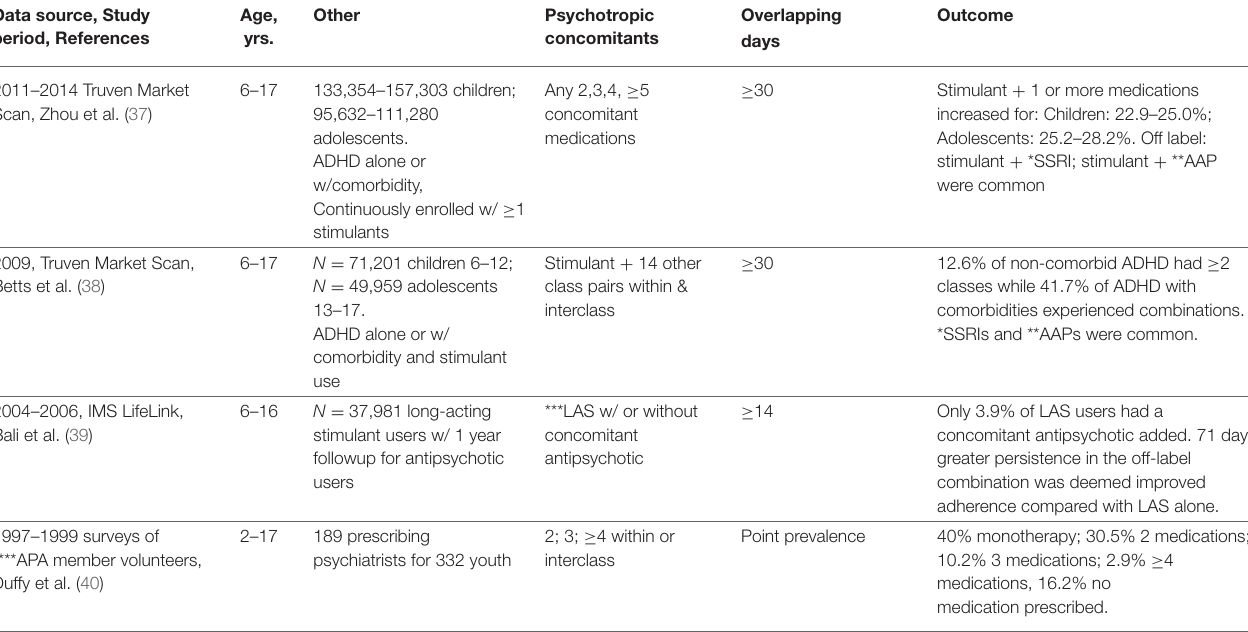
TABLE 3 | Pediatric psychotropic polypharmacy in privately insured